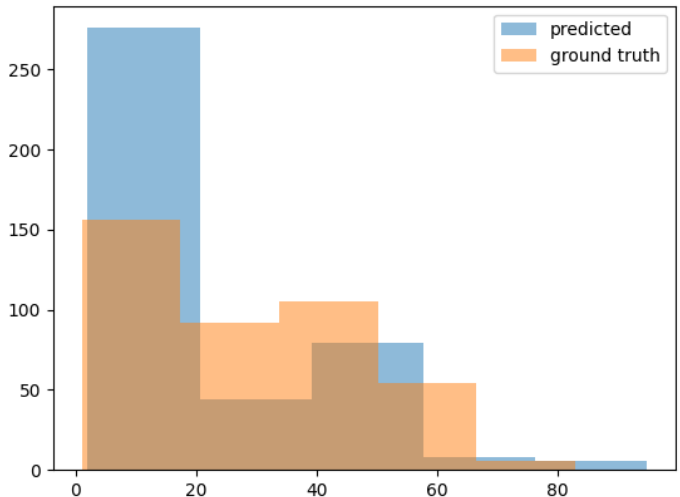
Figure 9. The age distributions of ground truth ages and predictions are